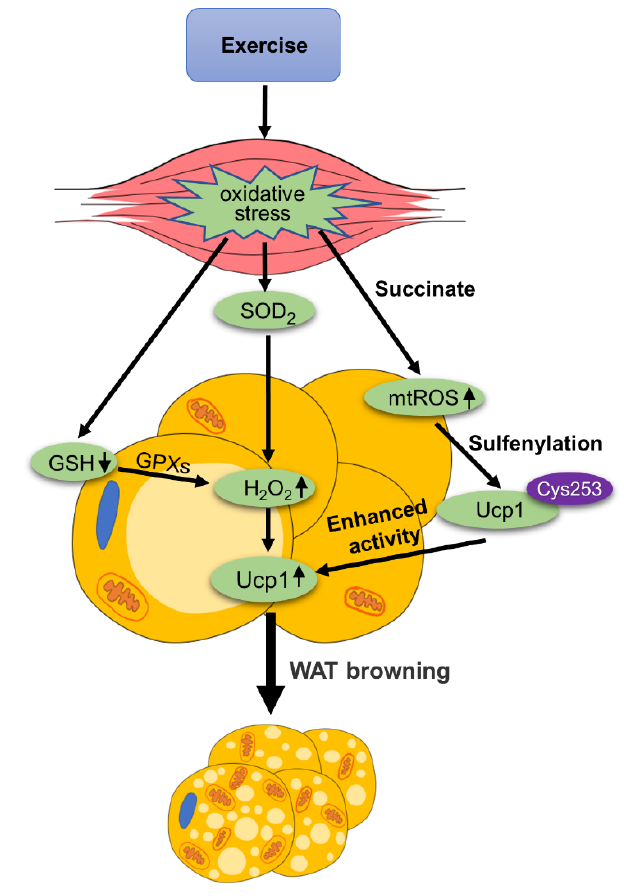
Figure 2. The role of ROS in exercise-mediated WAT browning. Exercise causes oxidative stress in skeletal muscle and reduces the level of GSH. GSH provides electrons for glutathione peroxidase (GPXs), which eliminates H 2 O 2 . Reducing GSH in WAT, can increase H 2 O 2 . Oxidative stress can